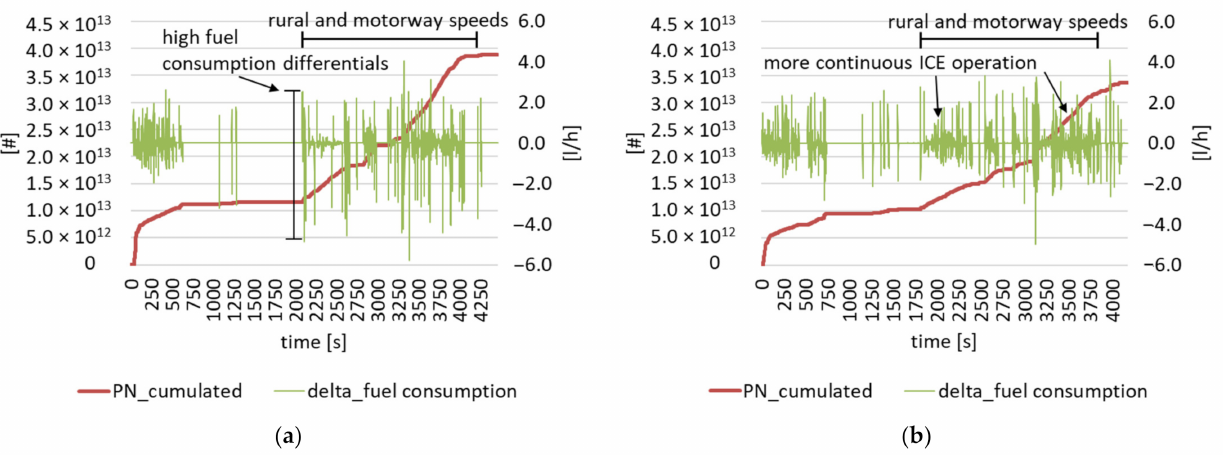
Figure 7. Comparison of the cumulative PN emissions and the fuel consumption differentials of a test in the hybrid driving mode ( a ) and a test in the sport driving mode ( b ). Both tests are performed during summer time.